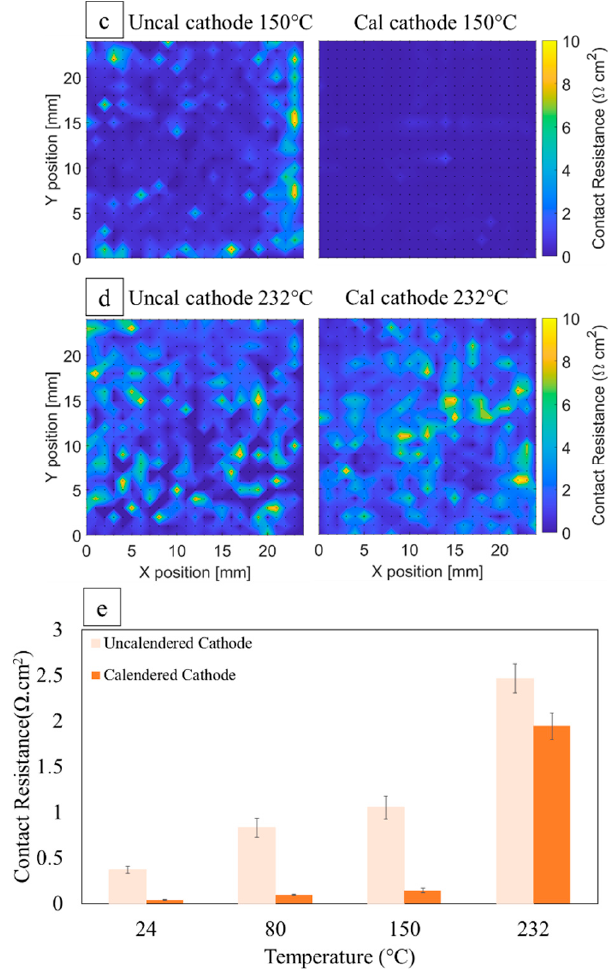
Figure 11. Contact-resistance maps of uncalendered and calendered cathodes dried at ( a ) 24 °C, ( b ) 80 °C, ( c ) 150 °C, and ( d ) 232 °C, and ( e ) comparison between the average contact resistances of ( b ) 80 ◦ C, ( c ) 150 ◦ C, and ( d ) 232 ◦ C, and ( e ) comparison between the average contact resistances of cathodes before and after calendering. cathodes before and after